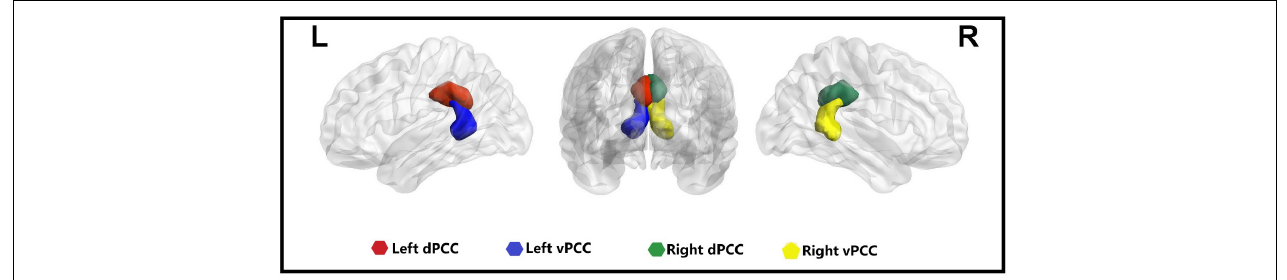
FIGURE 1 | Four seeds of the posterior cingulate cortex in the bilateral hemisphere. L, left; R, right; dPCC, dorsal posterior cingulate cortex; vPCC, ventral posterior cingulate cortex.